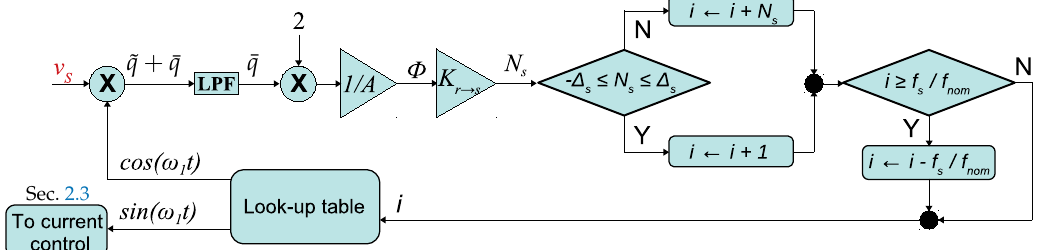
Figure 4. PLL to synchronize the AC with the installation site